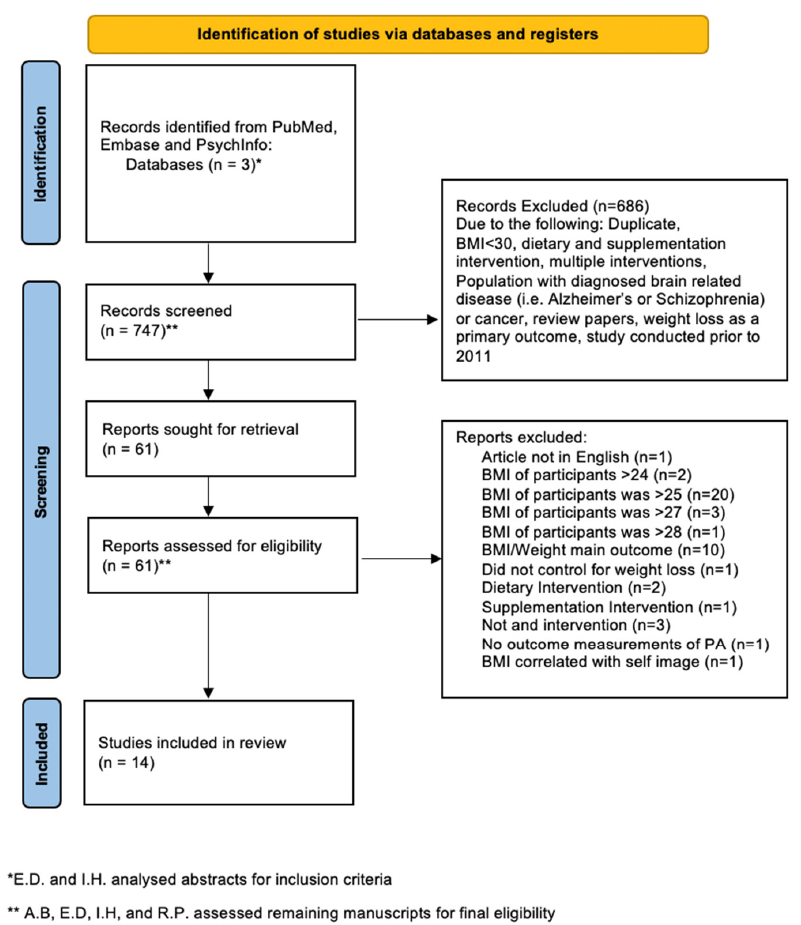
Figure 1. Flowchart depicting the choice of studies.